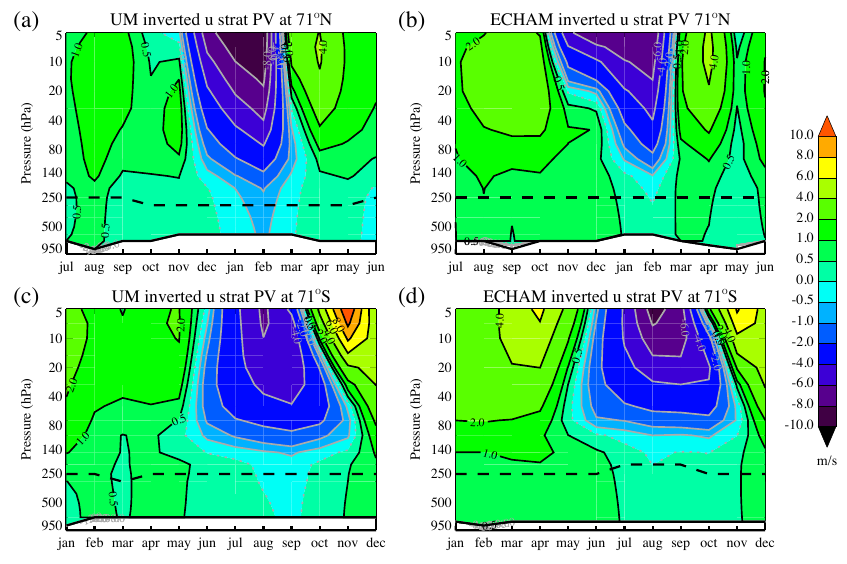
Fig. 10. Monthly zonal mean zonal wind response to CO 2 doubling, obtained from inverting the stratospheric PV between 400K and 1250K (in ms − 1 ), (a) at 71 ◦ N for the UM model, (b) at 71 ◦ N for the ECHAM model, (c) at 71 ◦ S for the UM model, and (d) at 71 ◦ S for the ECHAM model, as a function of time and pressure. Contours every 2ms − 1 with the ± 0.5 and 1ms − 1 contours added. Negative values are represented by grey lines and the zero contours by grey dotted lines.